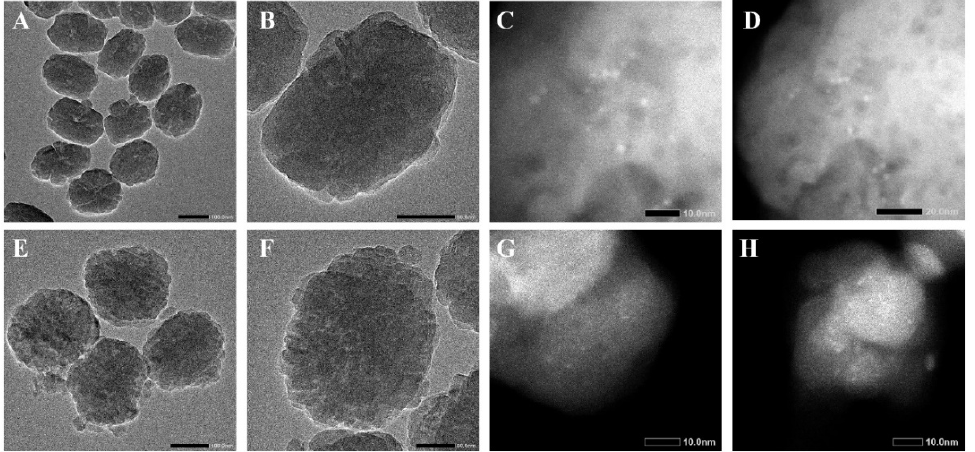
Figure 3. TEM and STEM-HAADF images of Cu 1.1 @NS ( A – D ), Cu 2.1 @NS ( E – H ).